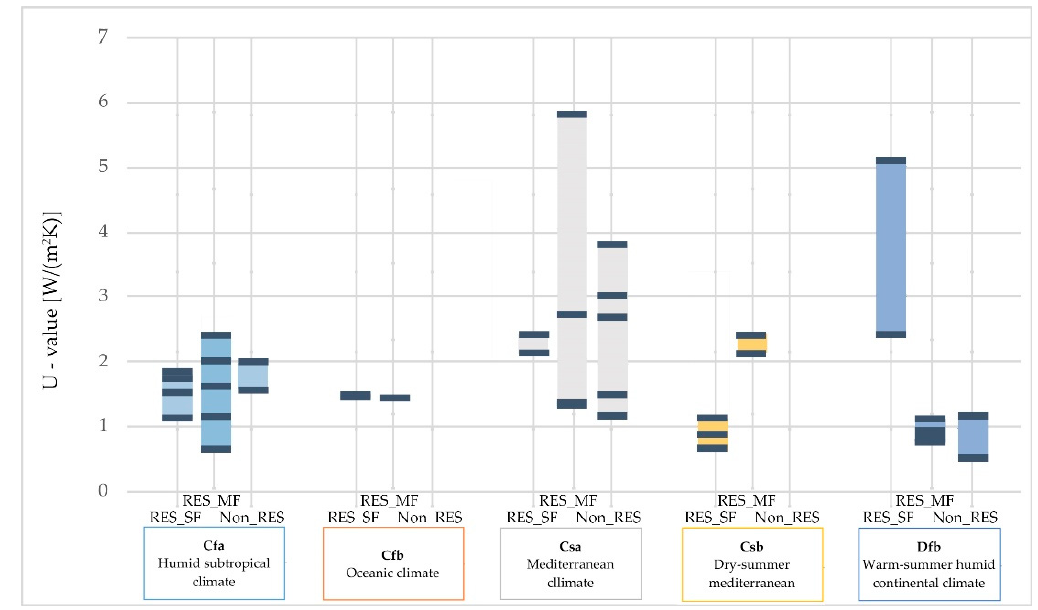
Figure 25. Optimal EEMs for windows—all building types.